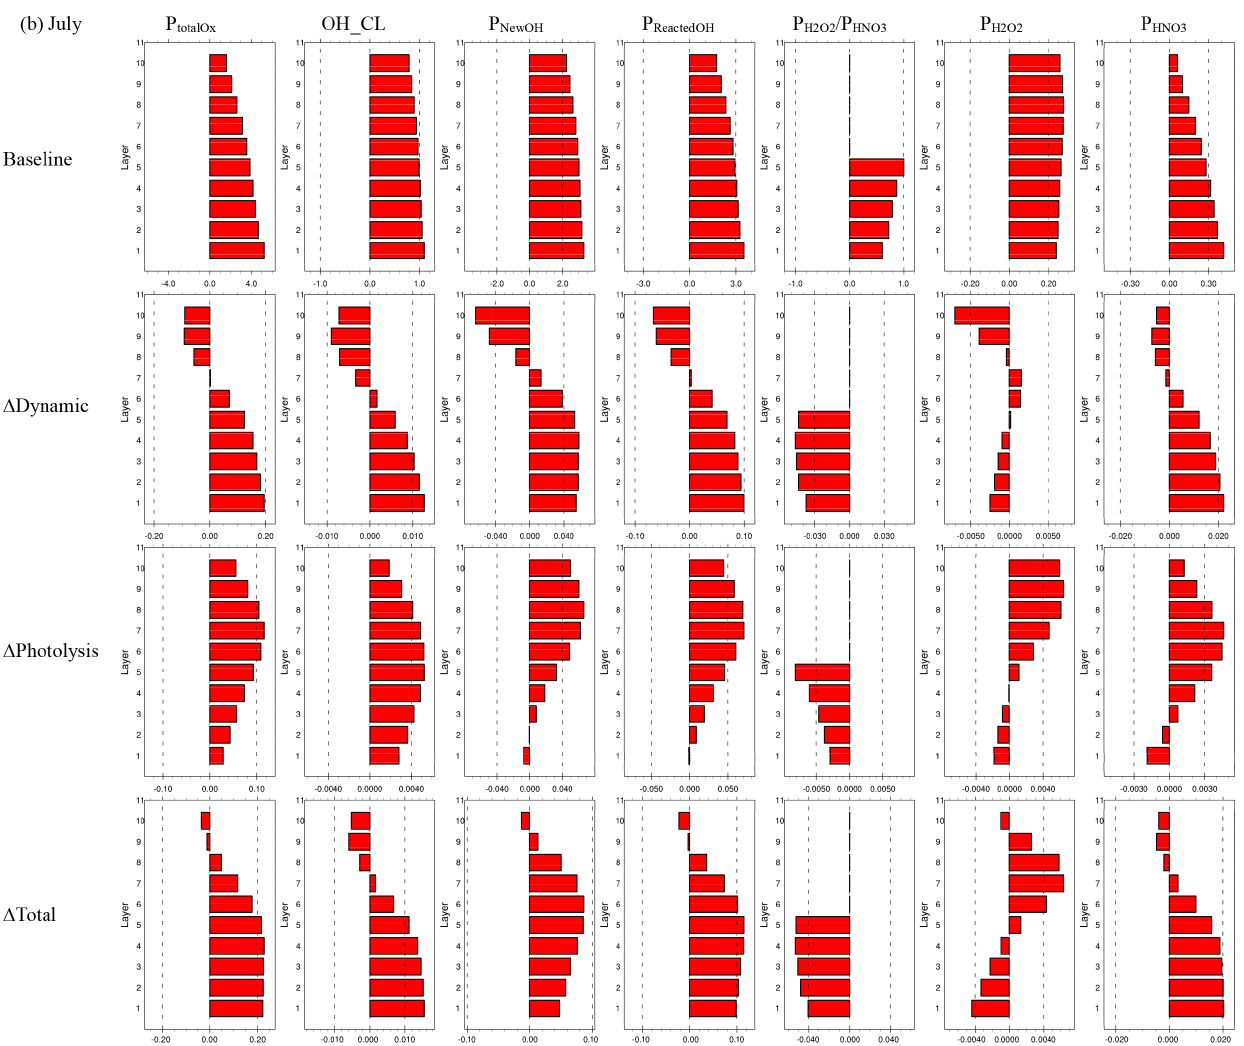
Figure 8. Vertical profile of integrated reaction rates in JJJ at noon. Full-layer heights above ground are 40, 96, 160, 241, 355, 503, 688, 884, 1100 and 1357m; baseline is the simulation in SimBL; (cid:49) Dynamic is the difference between SimSF and SimNF; (cid:49) Photolysis is the difference between SimNF and SimBL; (cid:49) Total is the difference between SimSF and SimBL; P totalO ppbh − 1 ); OH_CL is OH chain length; P NewOH is the production rate of new OH (unit: ppbh − 1 ); P ReactedOH is the production rate of reacted OH (unit: ppbh − 1 ); P H is the production rate of H 2 O 2 (unit: ppbh − 1 ); P HNO 2 O 2 /P HNO the ratio of P H is only shown for layers 2 O 2 3